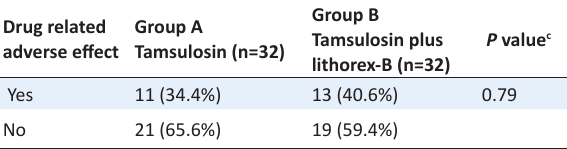
Table 3. Comparison the adverse effects of drugs in two